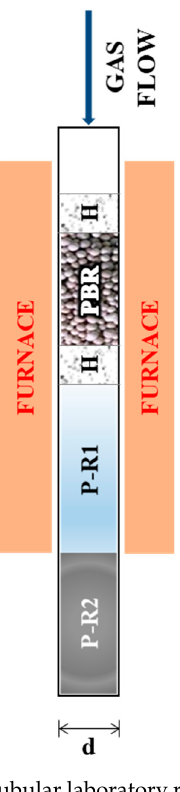
Figure 1. Schematic representation of the tubular laboratory reactor. PBR stands for packed bed reactor, P-R1 and P-R2 indicate the post reactor sections, H are the holders of the catalytic section, and d is the tube diameter. The same reactor geometry is employed for the CO 2 hydrogenation (MCO2) and steam methane reforming (SMR) experiments, with different dimensions (in Table 1). Table 1. Dimensions of the components of the tubular laboratory reactors used in MCO2 and SMR experiments.